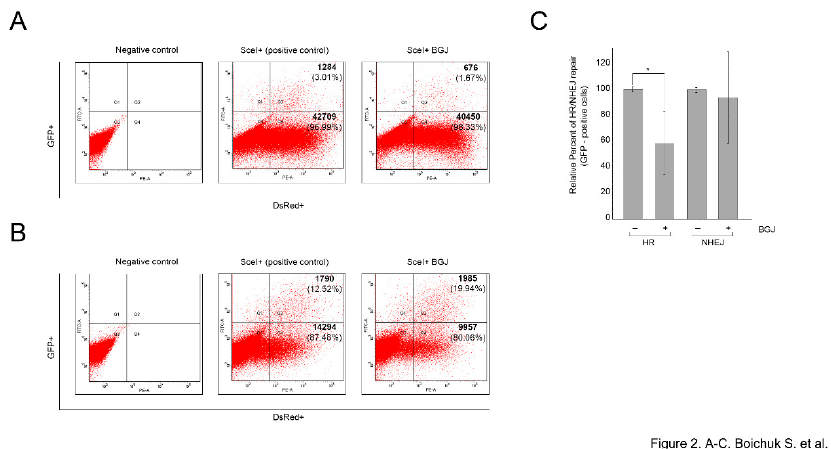
Figure 2. FGFR inhibition attenuates homology-mediated (HR) DNA repair in GIST. IM-resistant GIST-T1-HR ( A ) or GIST-T1-NHEJ ( B ) reporter cells were pre-cultured for 48 h with BGJ398 (1 µ M), followed by transfection of I-SceI plasmid to induce DNA DSBs, or an empty vector (negative control), for another 96 h. The transfection of pDS-Red2-N1 was used to assess transfection e ffi ciency. Percentages of GFP positive cells arising from HR or NHEJ were determined by flow cytometry. The e ffi ciency of HR and NHEJ was calculated as a ratio of GFP +/ DsRed + cells (the numbers of positive cells are shown in the right quadrants). The representative experiments are shown in A and B. ( C ) Graph illustrating a relative percentage of GFP-positive cells (in %) and SD from six independent experiments. ssDNA remains unaffected during inhibition of FGFR signaling in GIST.